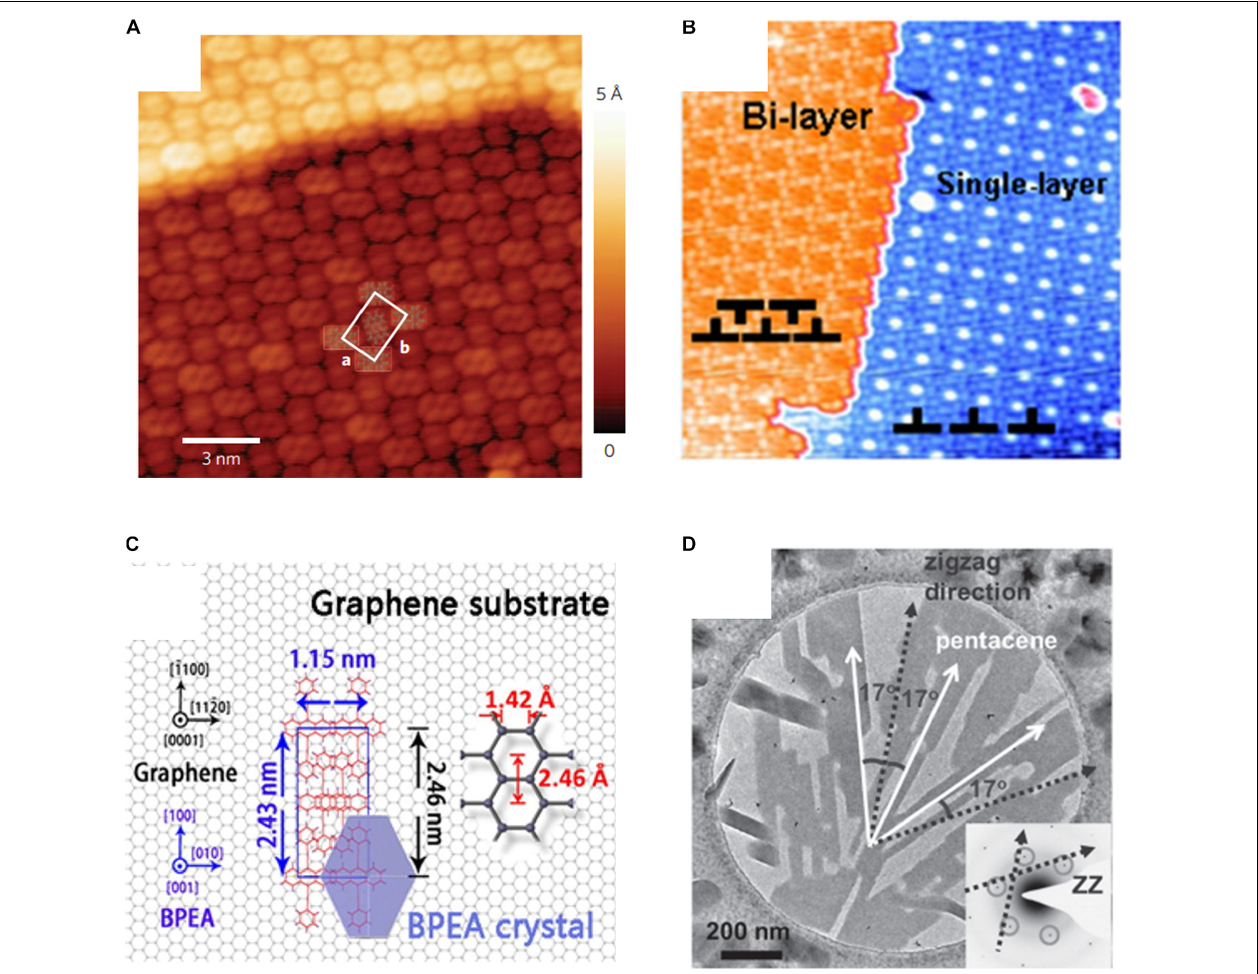
FIGURE 2 | Template growth of OSCs on graphene. (A) Molecular-resolution STM image of the PTCDA monolayer on graphene. Reproduced from Wang and Hersam (2009) with permission from Copyright 2009 Springer Nature. (B) STM image ClAlPc films on graphene including the single layer and bilayer packing. Reproduced from Mao et al. (2011) with permission from Copyright 2011 American Institute of Physics. (C) Schematic illustration of the lattice and epitaxy relationship between BPEA and graphene. Reproduced from Zheng et al. (2016) with permission from Copyright 2016 American Chemical Society. (D) TEM image of different areas where pentacene shows non-parallel crystal axis directions. Inset shows the electron diffraction of the underlying graphene membrane. Reproduced from Singha Roy et al. (2012) with permission from Copyright 2015